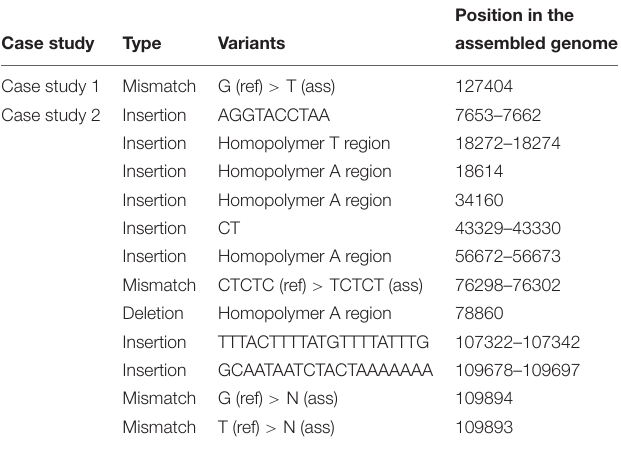
TABLE 4 | Variant calling for case studies 1 and